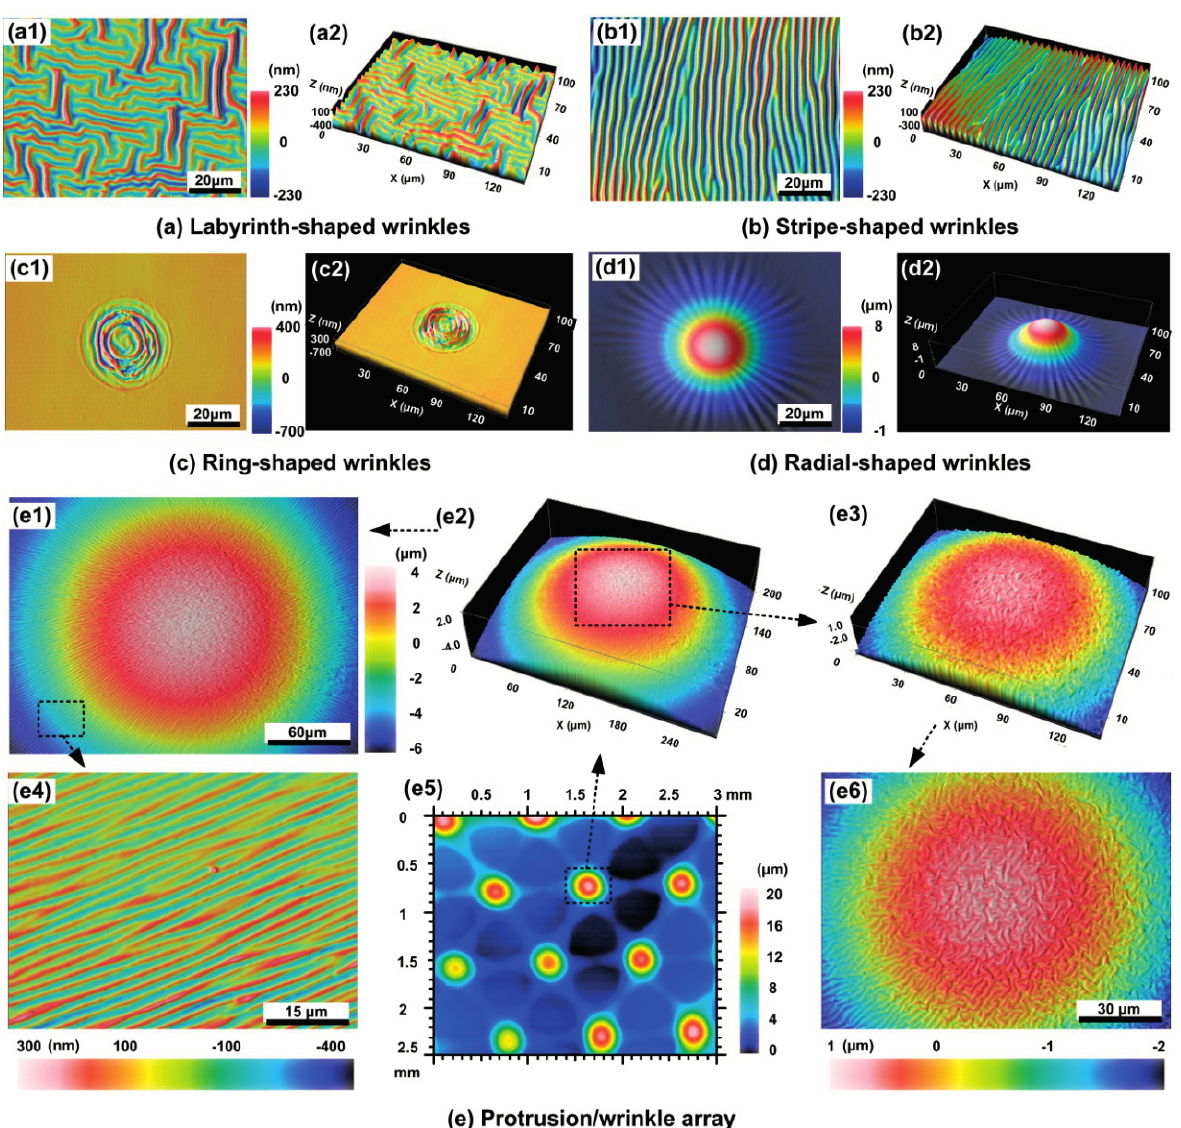
Figure 19. Wrinkling atop polymeric substrate. Reproduced with permission from Elsevier, 2013